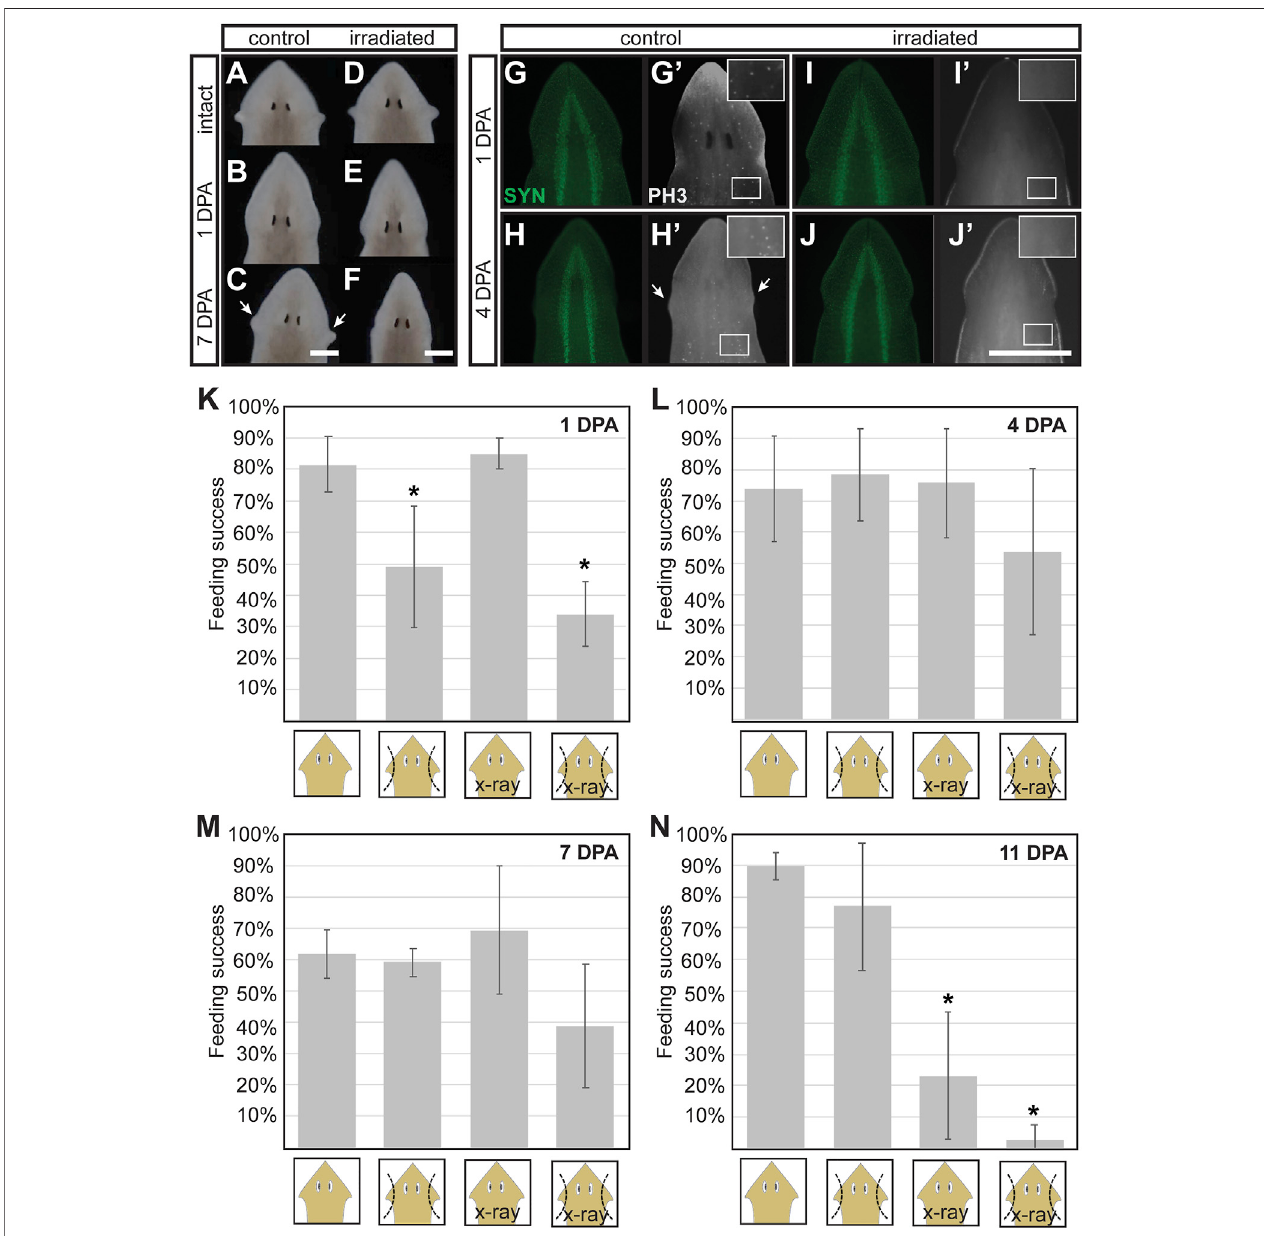
FIGURE 4 | Stem cell requirements for morphological and full functional recovery after auricle amputation. (A – F) Dark fi eld microscopy images of control [not irradiated; (A – C) ] and x-ray irradiated (D – F) G. dorotocephala shown before amputation (A,D) , 1 day post-amputation [DPA; (B,E) , and 7 DPA (C,F) ] reveal that irradiatedanimalsfailtoregenerate theauricles regeneratedbycontrolsamples7DPA(arrows). (G – J) Imagesofplanariansanalyzedbyimmuno fl uorescence usinganti- synapsin[SYT;green; (G – J) ]andphospho-HistoneH3[PH3, (G ’– J ’ ) ,white]antibodiesrevealthatmitoticstemcellspresentincontrolanimals (G ’ ,H ’ ) areabsentin irradiatedsamples (I,J ’ ) whiletheoverallstructureofthecentralnervoussystems(CNS)remainscomparable (G – J) . (K – L) Averagepercentfeedingsuccessofintact(1st and 3rdbaringraphs) andauricle amputee(2nd and4thbars pergraph)control(1stand2ndbars)and irradiated (X-ray;3rdand 4thbars) planariantested 1 (K) ,4(L),7 (M), and 11 (N) days post-amputation (DPA). Averages calculated from at least 3 biological replicate groups of at least 7 planarians each. Error bars indicate standard deviation from the mean. Asterisks (*) indicate statistical signi fi cance according to Students ’ t- test p- value < 0.05 when compared to intact control samples.